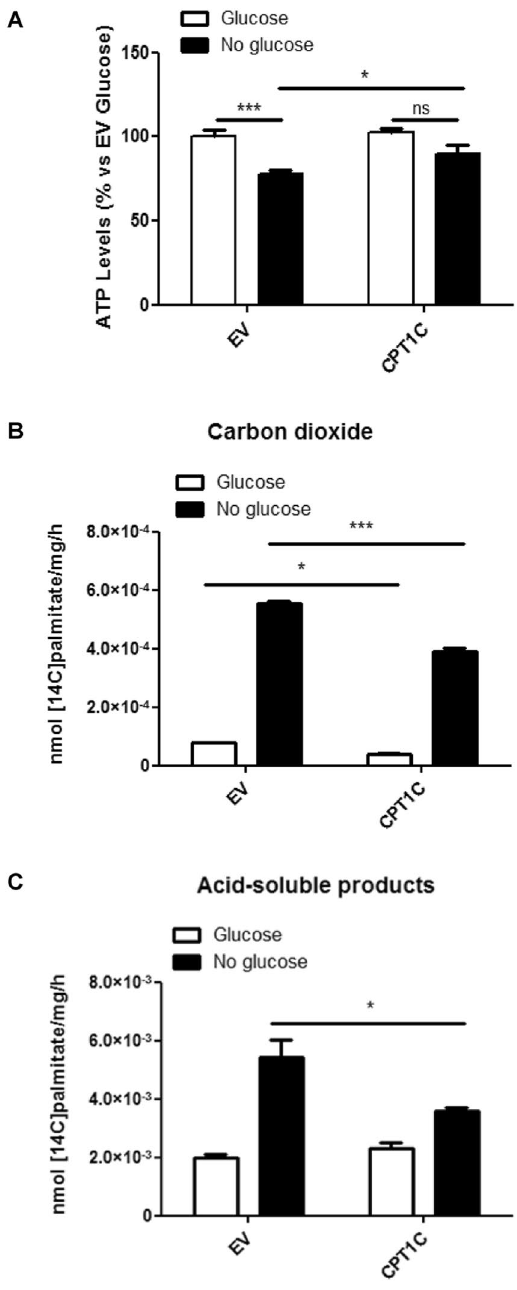
Figure 3. CPT1C overexpression in hMSCs leads to higher ATP production in glucose deprived media even though maximal FAO capacity is not increased compared to control cells. ( A ) ATP levels were measured in EV or CPT1C-hMSCs in the presence (white bars) or the absence (36 h) (black bars) of glucose. Results are shown as mean ± SEM of 3 independent experiments performed in triplicate. ( B , C ) FAO was determined in EV or CPT1C-hMSCs in the presence (5 mM) or absence of glucose (24 h). nmol ( 14 C) palmitate/mg/h converted to carbon dioxide ( B ) and ASP ( C ) were measured. Results are shown as mean ± SEM of triplicate. * p < 0.05; *** p <